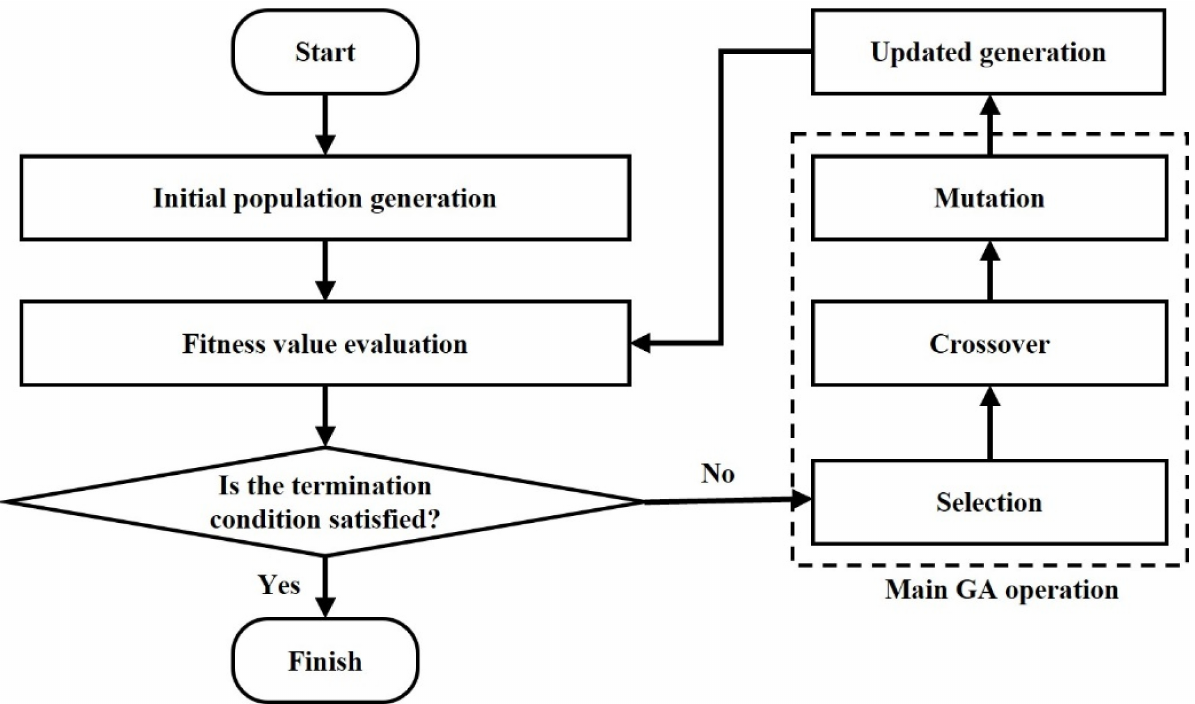
Figure 3. The overall process of genetic